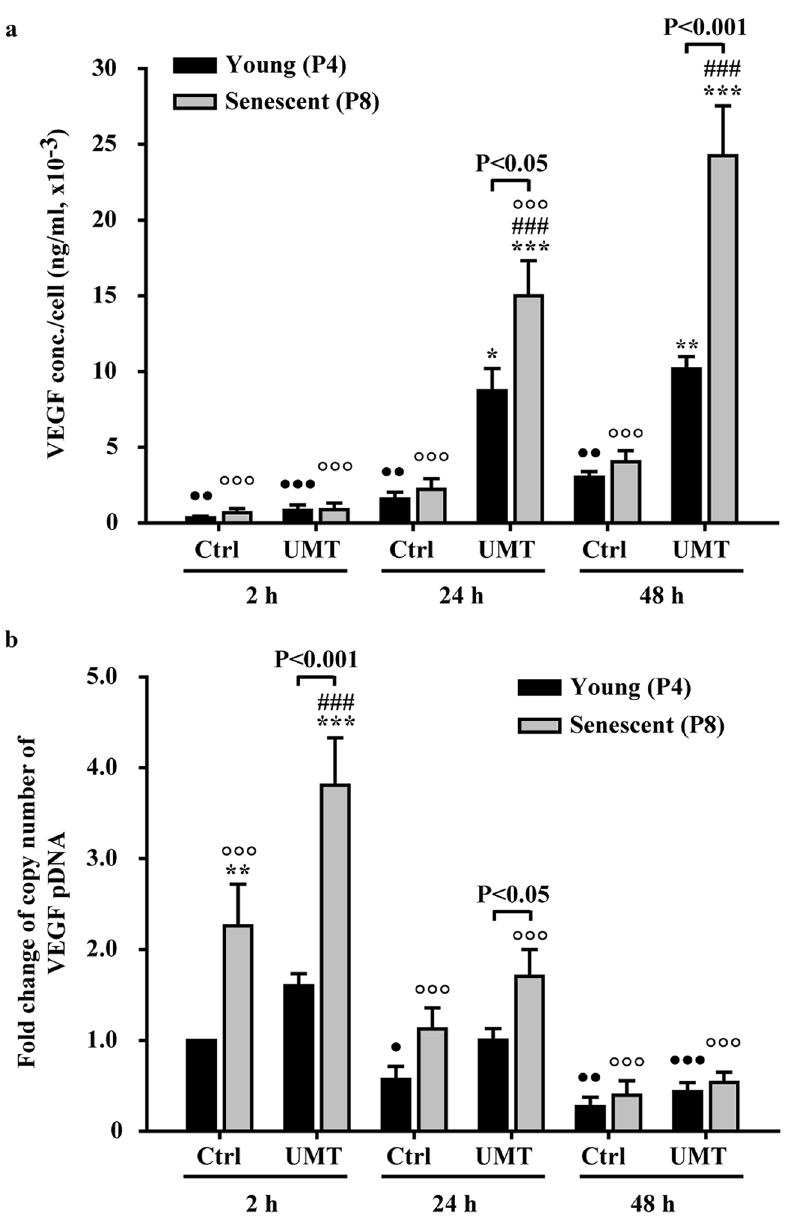
Figure 4. Comparison of VEGF protein levels in the supernatants ( a ) and intracellular pDNA copy numbers ( b ) at 2 h (h), 24 h and 48 h post UMT of VEGF pDNA into young and senescent EPCs. ( a ) ELISA and ( b ) quantitative PCR. See the text for details. n = 7 for each bar. * P < 0.05; ** P < 0.01; *** P < 0.001 vs. the leftmost black bar at the same time point. ### P < 0.001 vs. the leftmost grey bar at the same time point. • P < 0.05; •• P < 0.01; ••• P < 0.001 vs. the highest corresponding black bar and °°° P < 0.001 vs. the highest corresponding grey bar in ( a ) and ( b ). Note that for the UMT groups at the same time points, differences between the black and grey bars are indicated. All abbreviations are the same as those used in Fig.